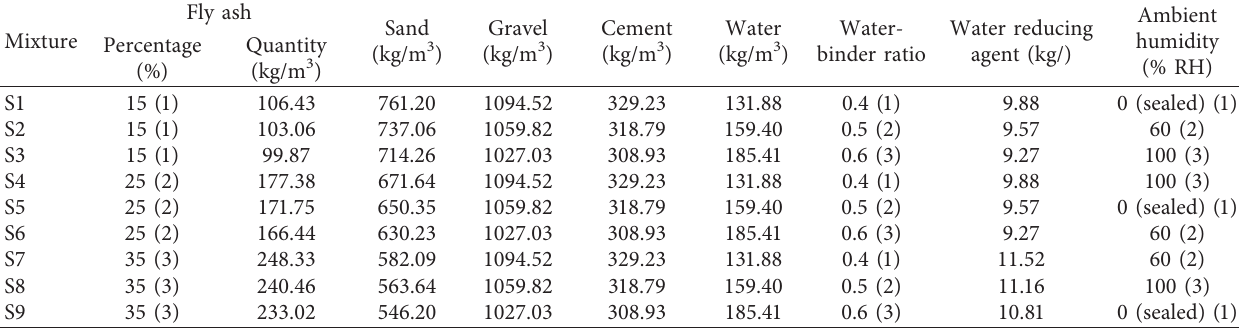
Table 3: Concrete mixtures used for orthogonal analyses.